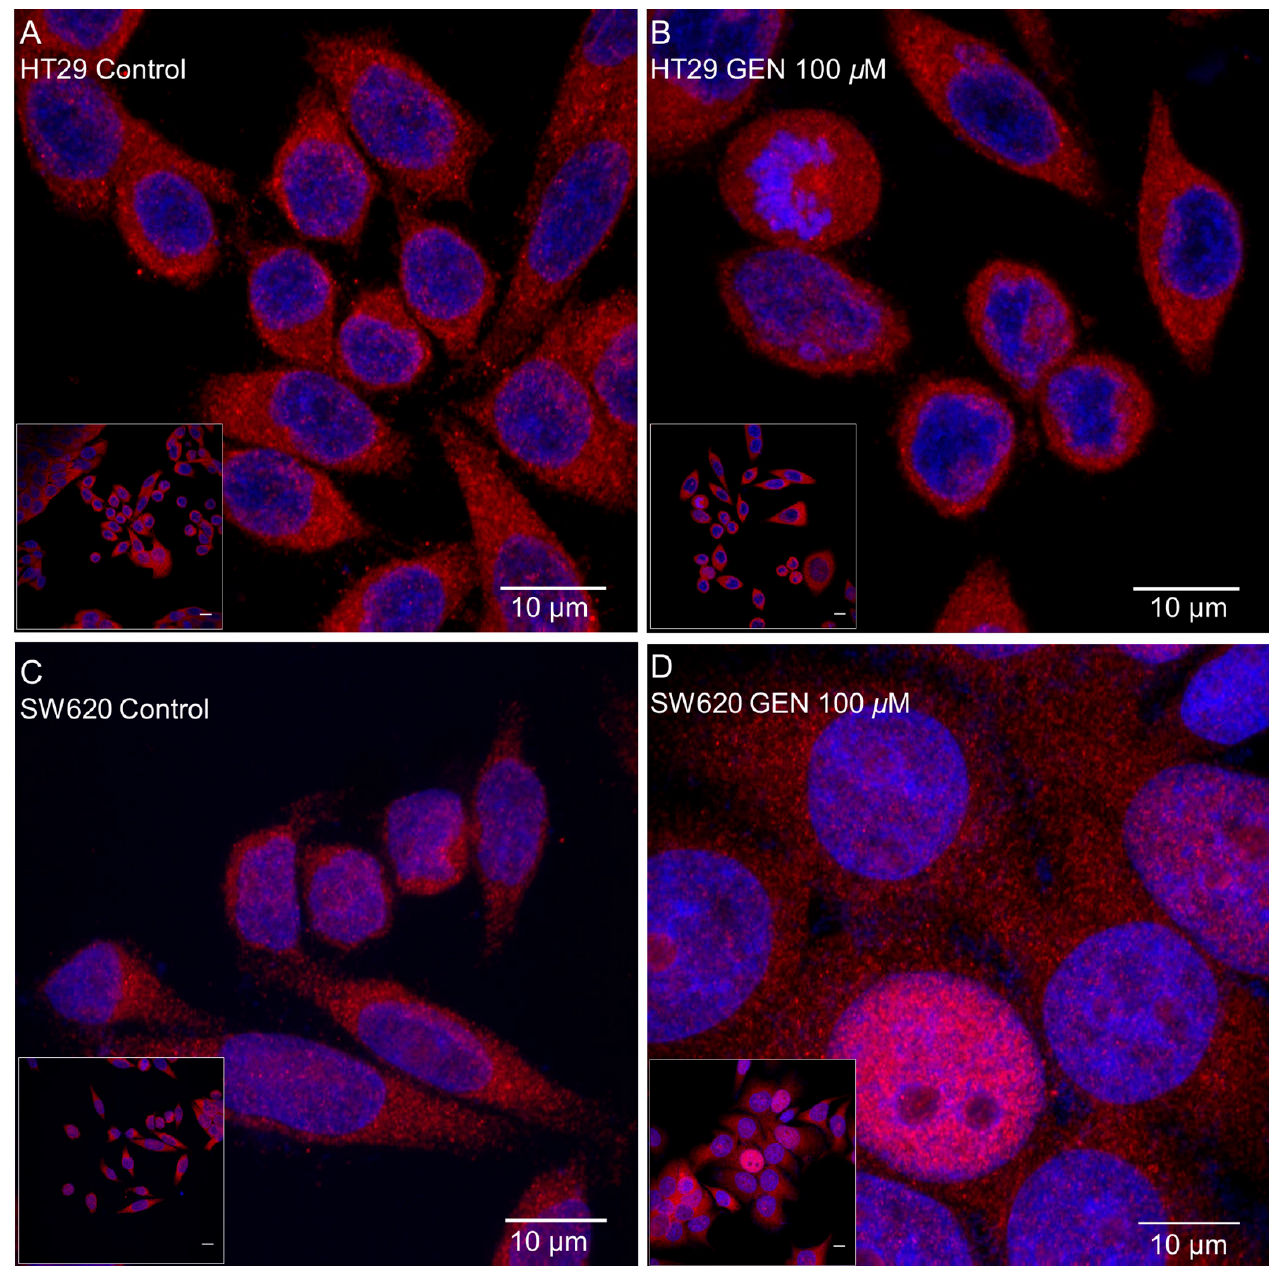
Figure 9. Effects of genistein on NF- κ B nuclear translocation in ( A , B ) HT29 cells and ( C , D ) SW620 cells determined by immunocytochemistry. The measurements were made with 0.1% DMSO (control cells, ( A , C )) or genistein 100 µ M ( B , D ) treatment for 48 h. The fluorescence was monitored with a Leica TCS-SPE Confocal Microscope, using 63 × immersion oil (147 N.A.) objective lens. Scale bar 10 µ m. White square in the bottom left corner shows the whole field without zoom and the image in the center shows a zoom from the white square image. Nucleus and NF- κ B proteins are represented in the picture in blue and red, respectively. The merge between both (pink) indicates that NF- κ B had translocated into the